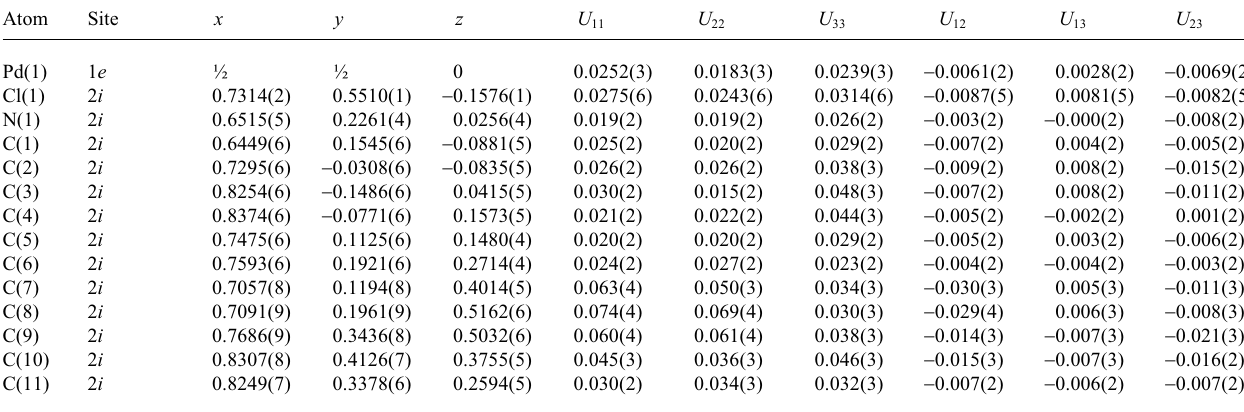
Table 3. Atomic coordinates and displacement parameters (in Å 2